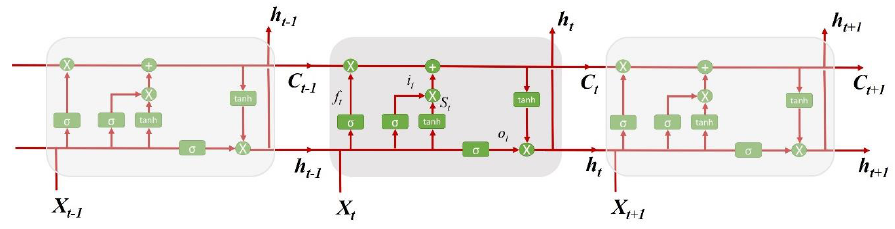
Figure 5. The structure of a long short-term memory network.